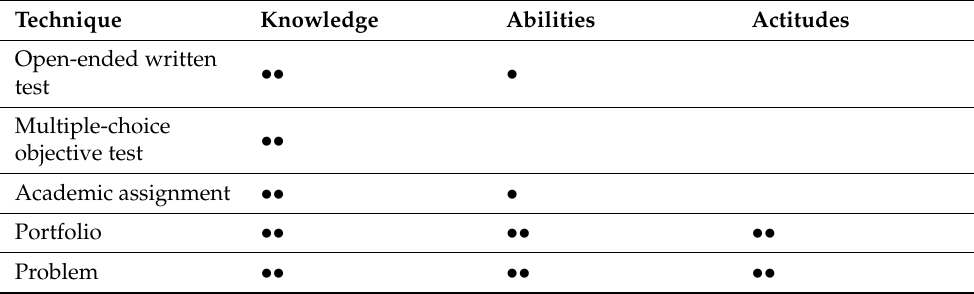
Table 4. Evaluation techniques used in the course on energy